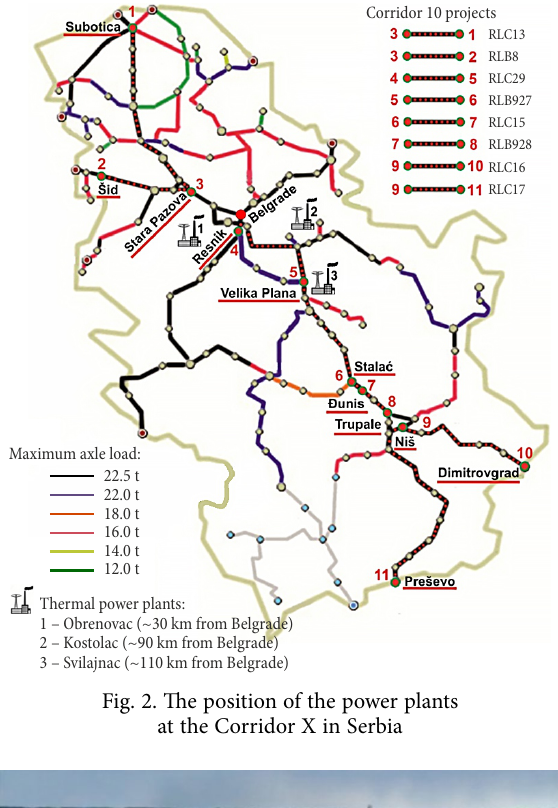
Fig. 2. The position of the power plants at the Corridor X in Serbia